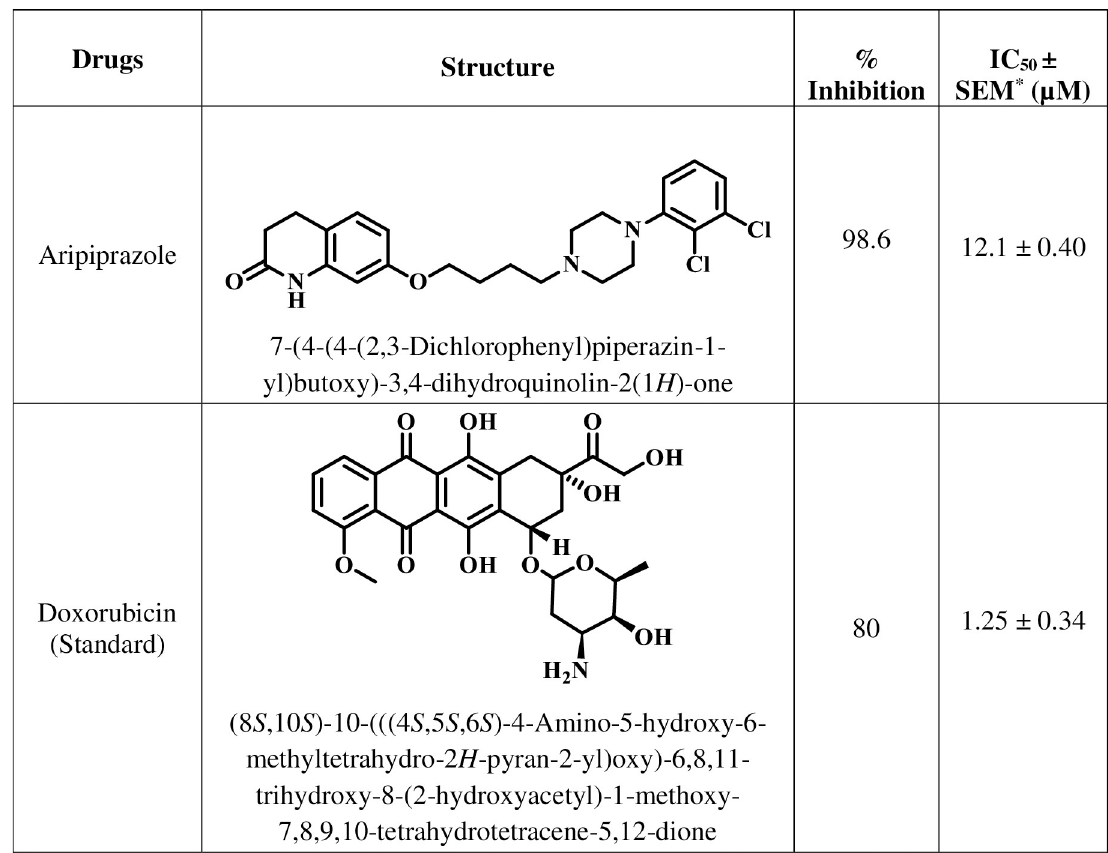
Fig 1. Antipsychotic drug evaluated in the present study. https://doi.org/10.1371/journal.pone.0235676.g001 cell proliferation. Cell apoptosis assay was performed by staining the cells with annexin V-FITC and PI, through flow cytometry (Fig 4). The presence of only annexin V-FITC positive